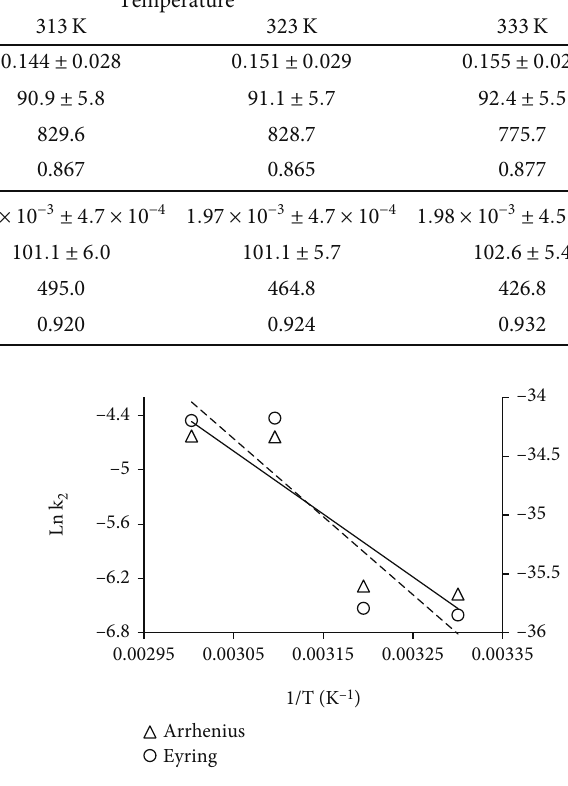
Figure 5: Arrhenius and Eyring plots for the adsorption of BF onto